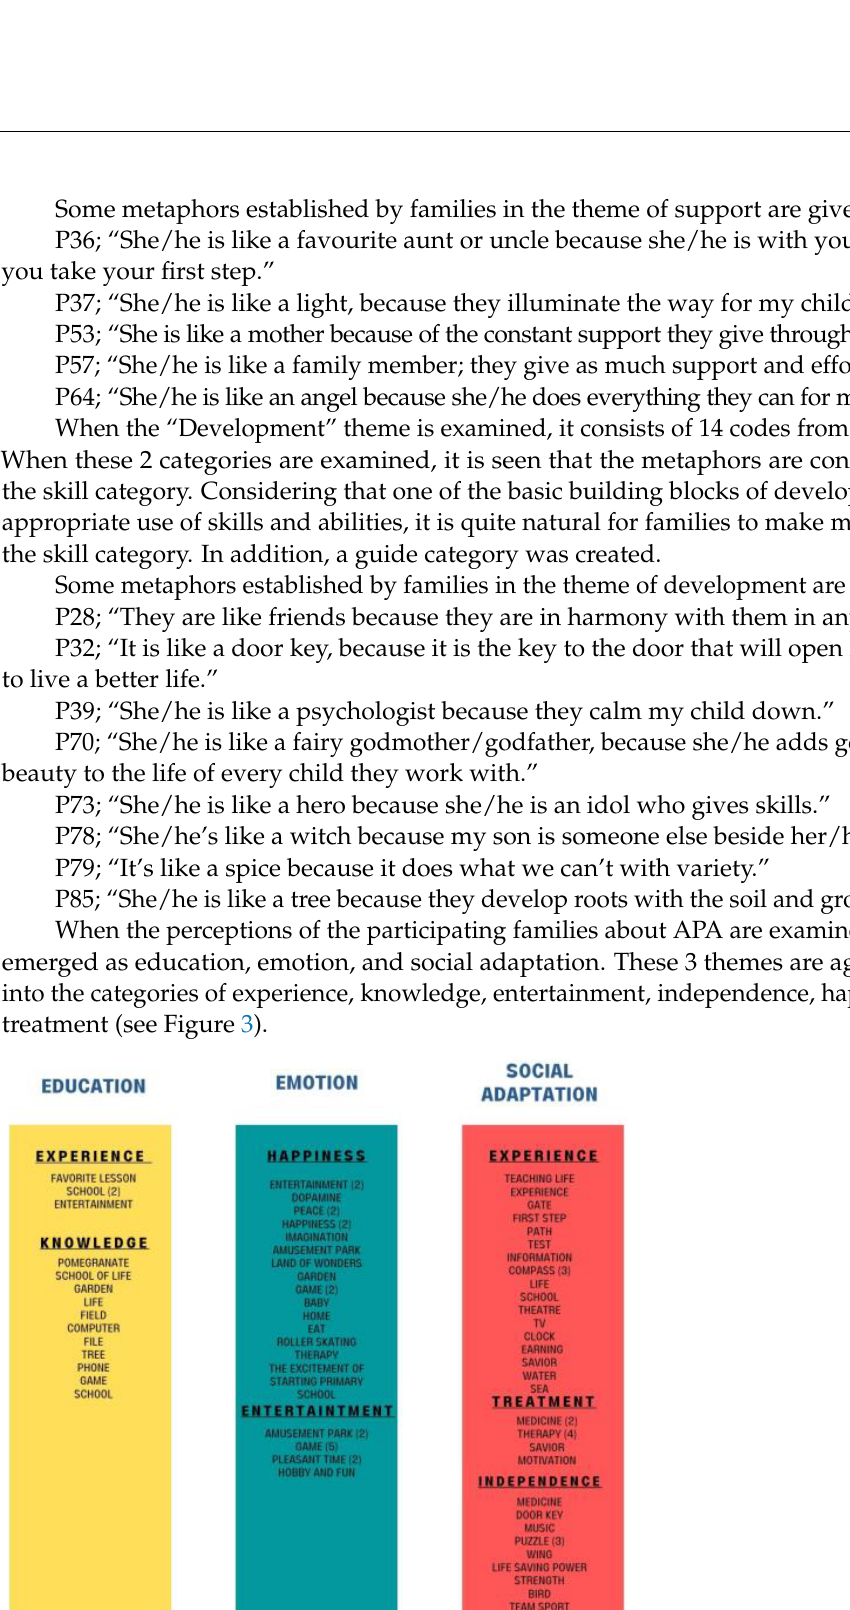
Table 8. Distribution of categories and codes for the metaphors that families produced about edu- cators about APA.